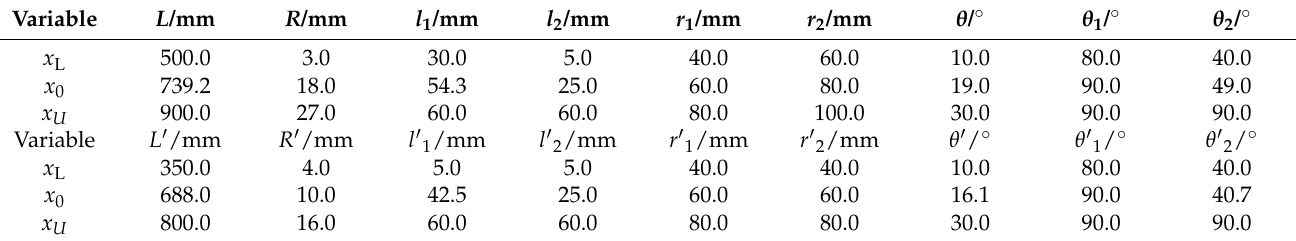
Figure 2. Schematic diagram of the L , R , θ , l 1 , l 2 , r 1 , r 2 , θ 1 , θ 2 in grain part III. Table 1. Initial values and range of values for the design variables of the SRM grain.